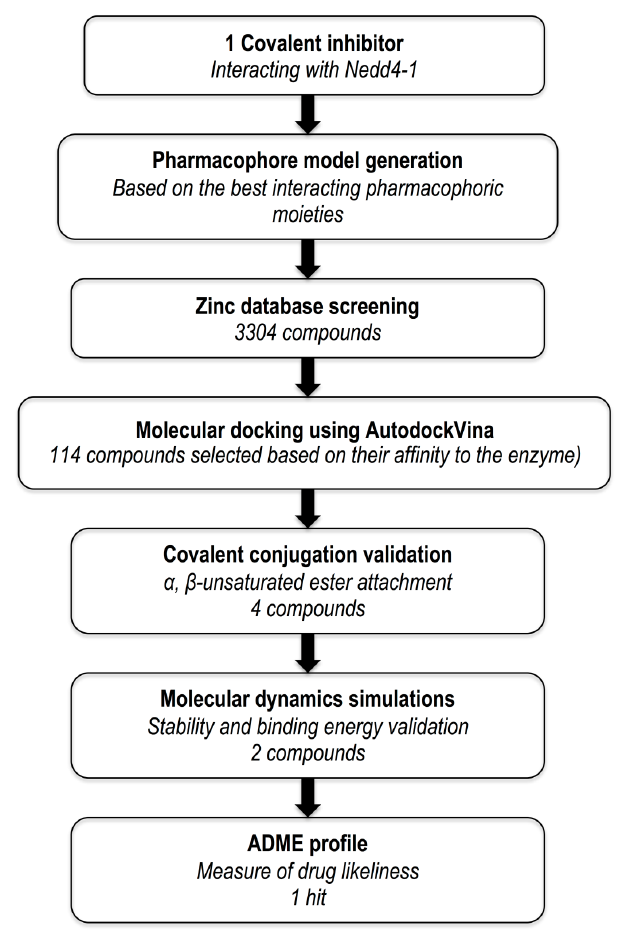
Figure 3. Outline of computational protocol and implemented filters.